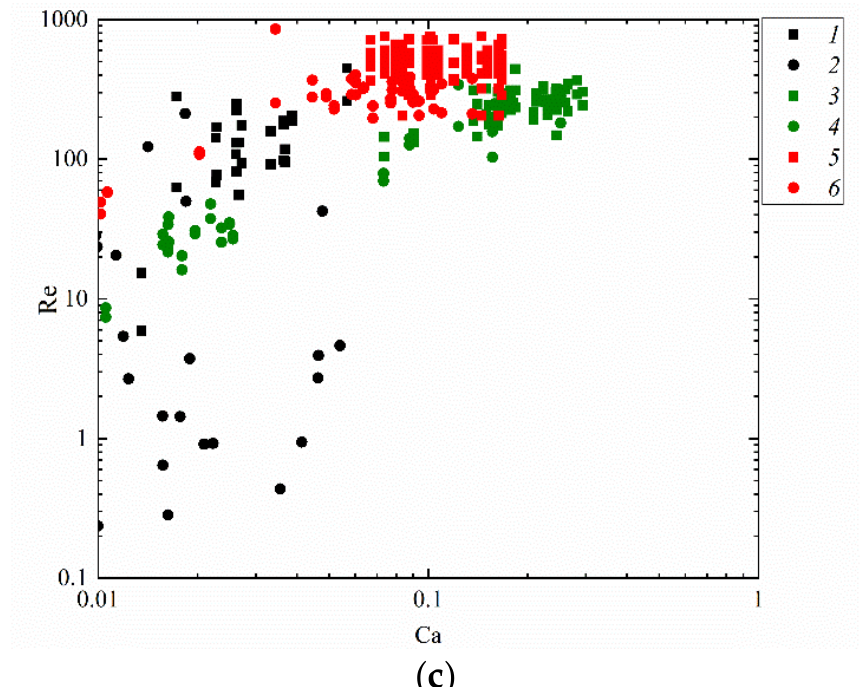
Figure 11. Effect of liquid properties on the transition boundary between agglomeration and stretch- ing separation during the collision of a droplet with a solid particle ( a ), with another droplet ( b ) [45] and with a solid substrate ( c ): 1, 2—water; 3, 4—50 vol% water and 50 vol% glycerol; 5, 6—10 vol% water and 90 vol% diesel; 1, 3, 5—stretching separation; 2, 4, 6—agglomeration.